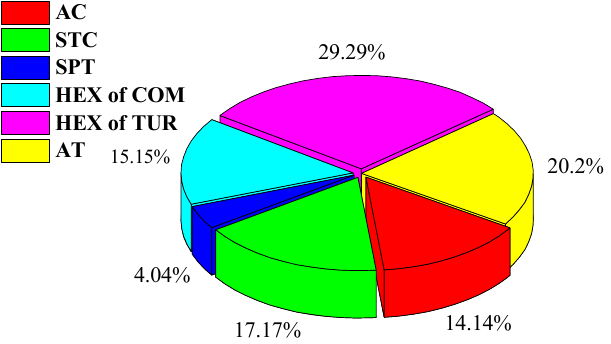
Figure 4. Exergy destruction of each subsystem.